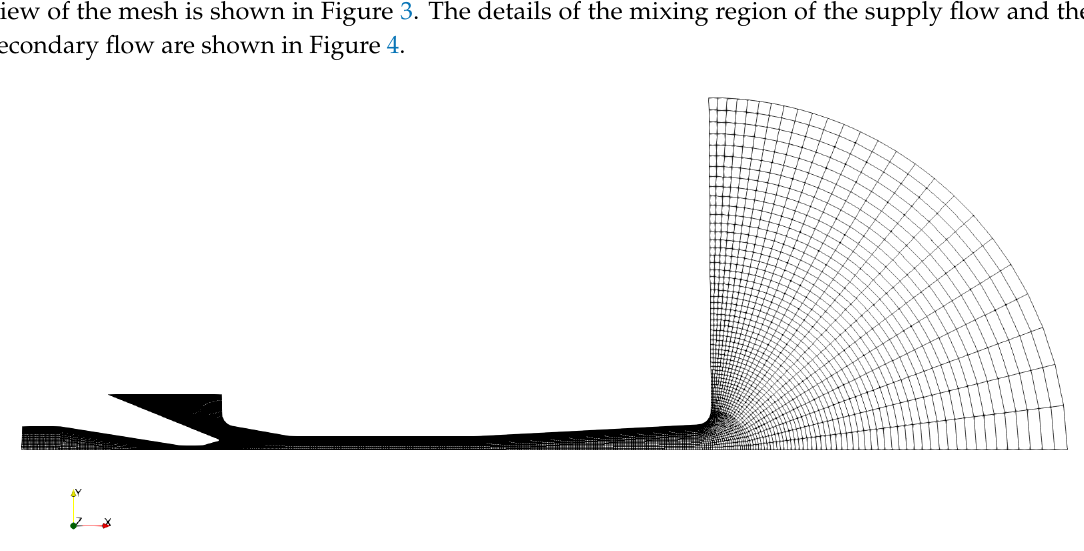
Figure 3. General view of the